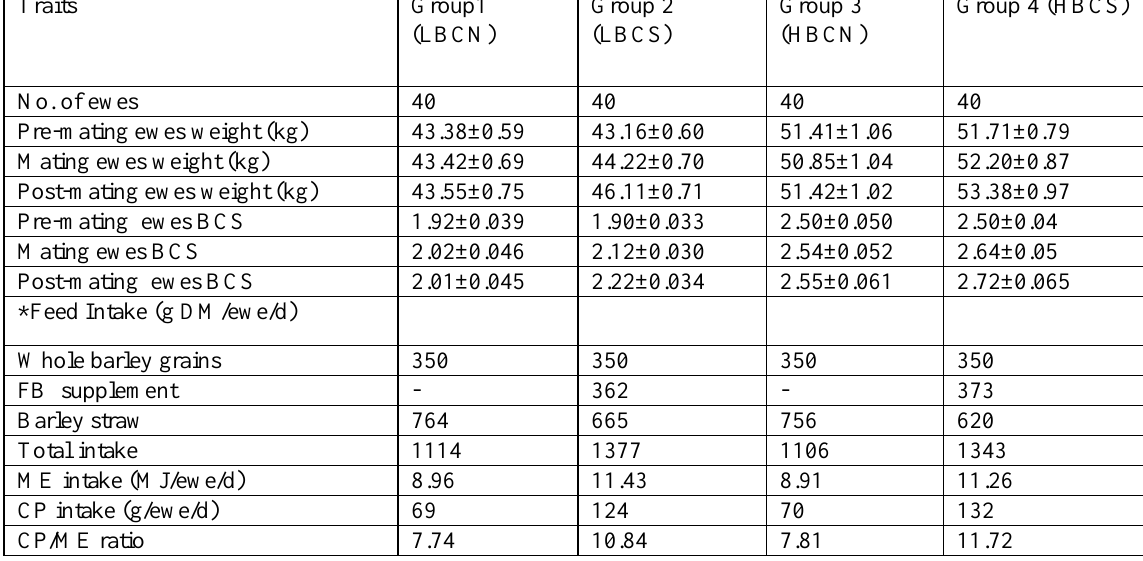
Table 2: Effect of initial BCS and supplementary feed on the ewes’ BCS and live weights and feed intake Traits